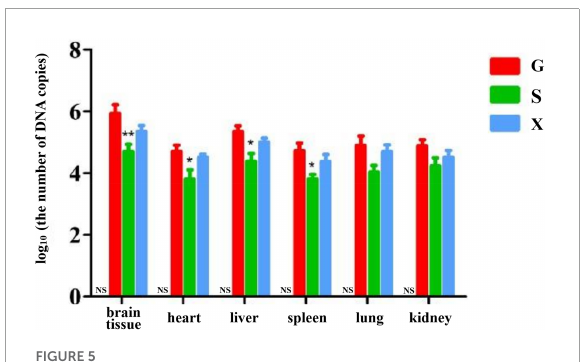
FIGURE5 Organ parasite burden of mice with reactivation of Toxoplasma gondii infection. C: no T. gondii + DEX + PBS; G: 3 T. gondii cysts + DEX + PBS; S: 3 T. gondii cysts + DEX + koumiss; X: 3 T. gondii cysts + DEX + mare’s milk. All data are expressed as mean ± SD. * P < 0.05; ** P < 0.01 and NS, no significance between Group C and other